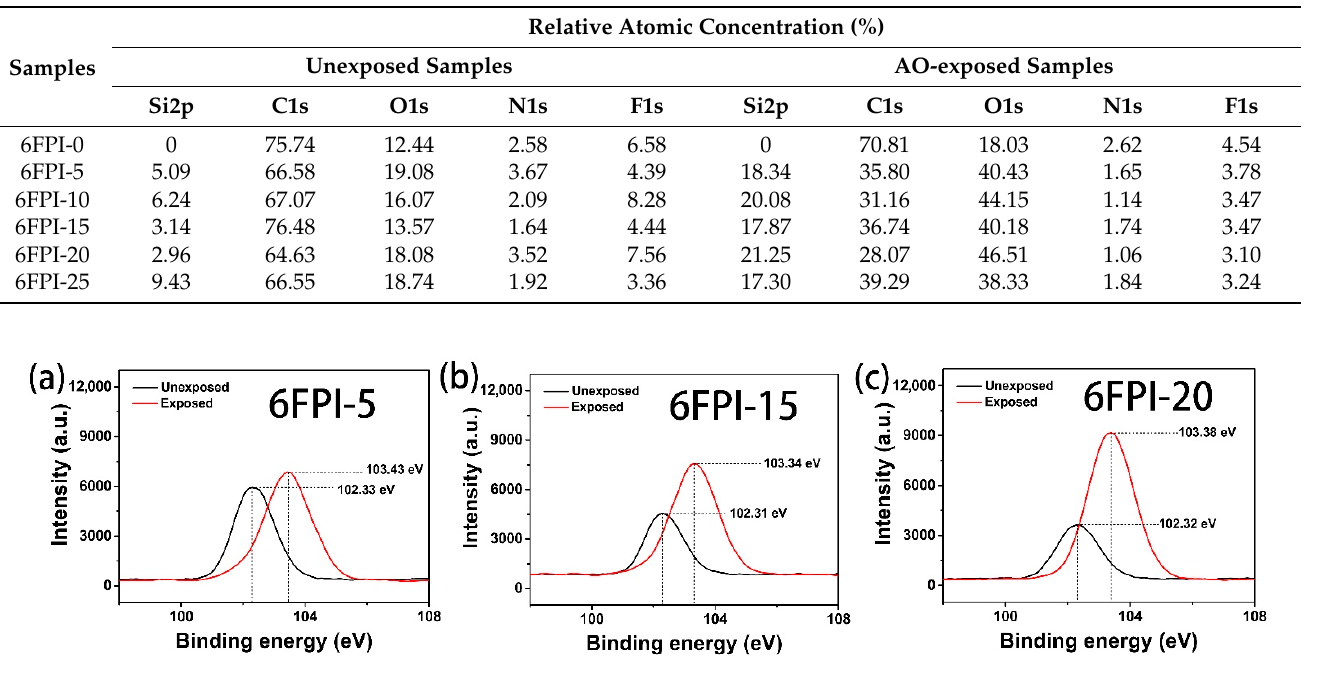
Figure 18. XPS spectra of Si2p for AO-exposed and unexposed 6FPI-POSS composite films with total AO fluence of 4.02 × 10 20 atom/cm 2 . ( a ) 6FPI-5; ( b ) 6FPI-15; ( c ) 6FPI-20.